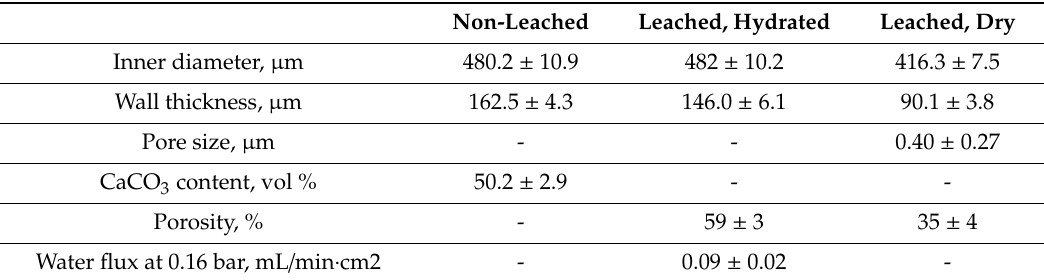
Table 5. Parameters of SLA-printed vascular